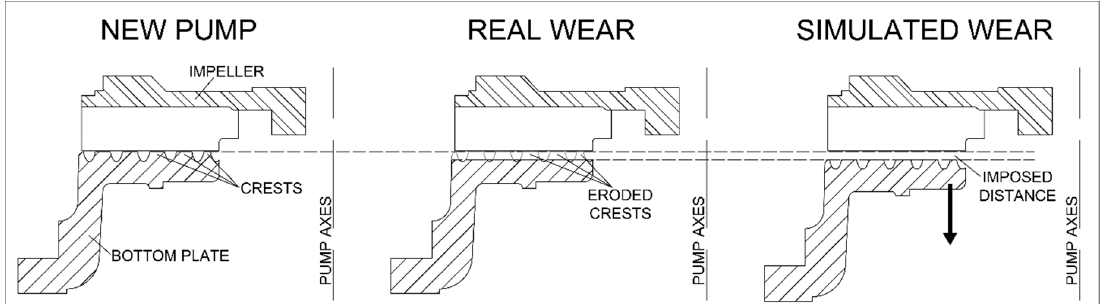
Figure 5. Sketch of the pump section and effect and simulation of the erosion.